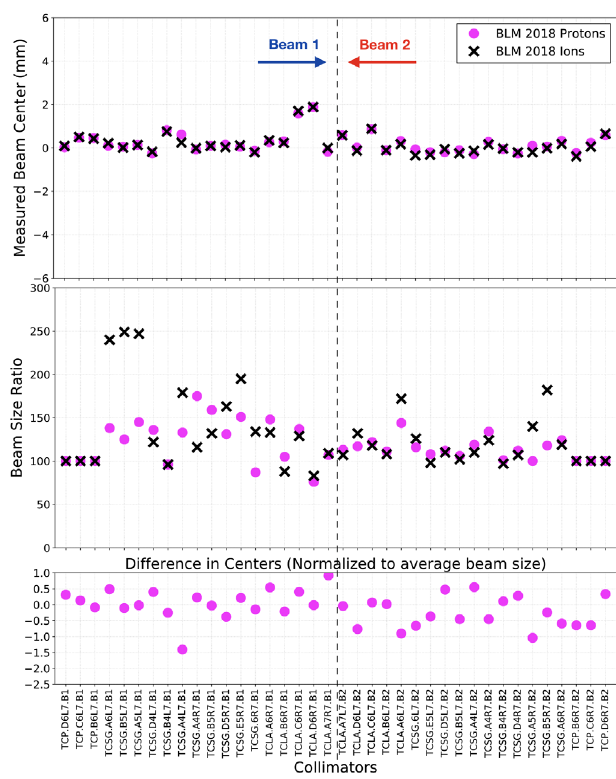
FIG. 17. Ion commissioning IR7 BLM results in collisions comparing the beam centers and beam size ratios to flattop commissioning